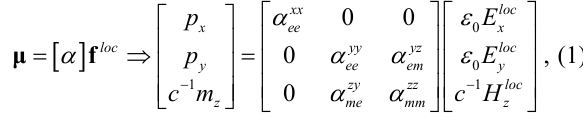
Figure 2: The first metasurface of bianisotropic scatterers at the x = 0 plane. The periods of the lattice along the y - and z - [12], which z direction, are b and a , respectively. A TEM wave propagat- ing along the x -axis impinges normally on the metasurface.